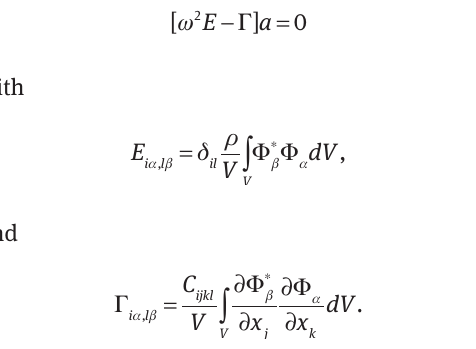
Table 1: dilational, flexural, and torsional modes. In the